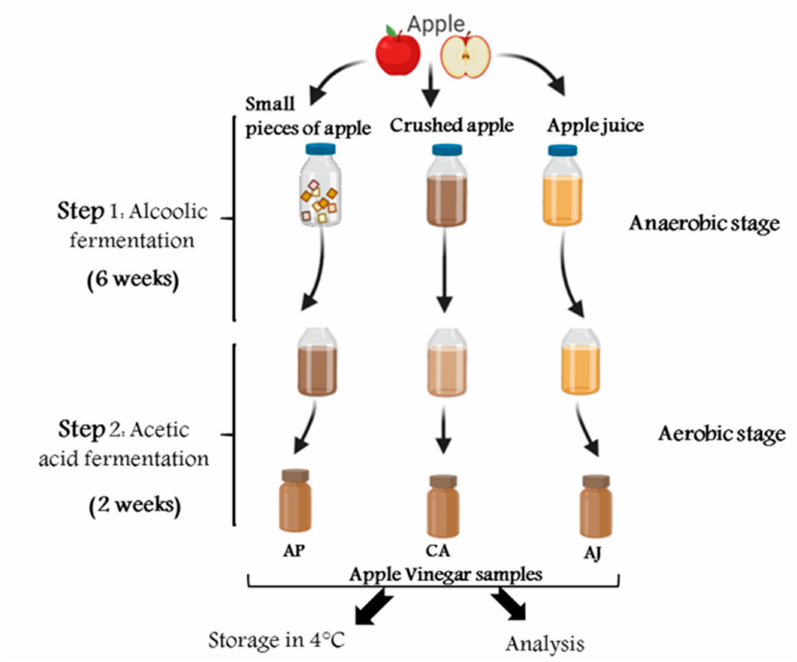
Figure 2. Summary of apple vinegar processing methods used in this